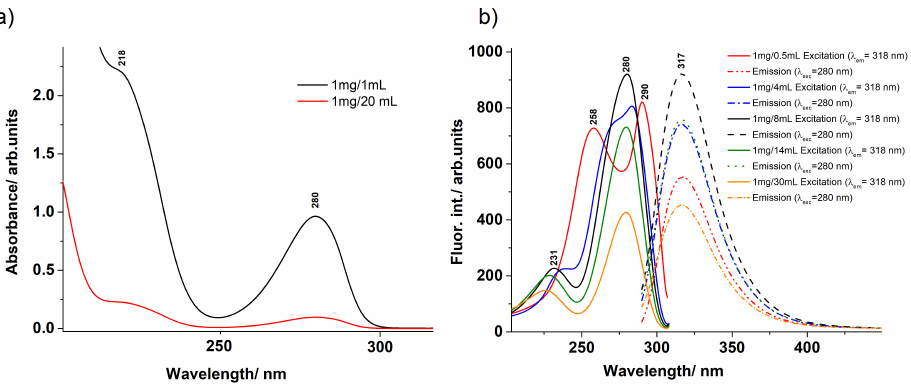
Figure 1. ( a ) The experimental UV absorption spectra obtained for the concentrated (black) and diluted (red) aqueous DA solutions. ( b ) The fluorescence emission (dashed lines) and excitation (continuous lines) spectra obtained for the aqueous DA solution with different DA